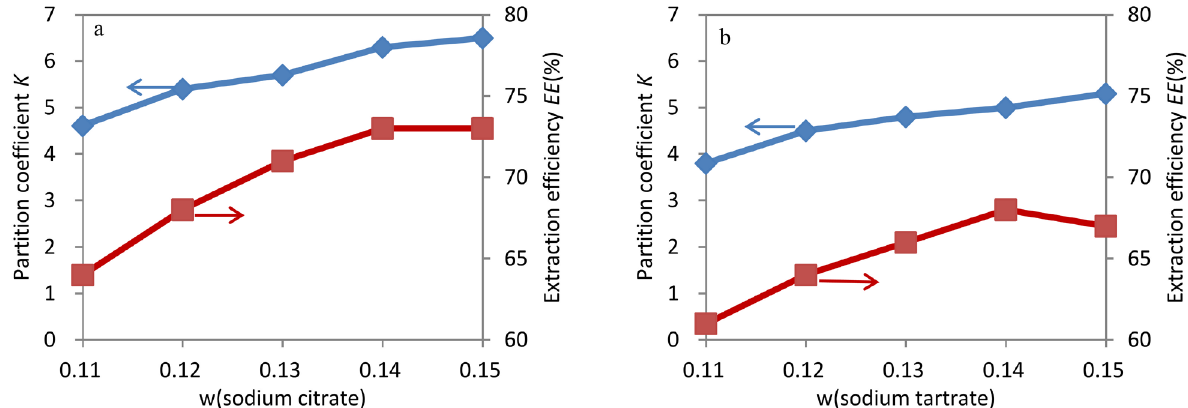
Figure 4: Dependence of Partition coefficient K and extraction efficiency EE on total mass fraction of salt in ATPS of (a) PEG 10000 + sodium citrate + H O and (b) PEG 10000 + sodium tartrate + H 2